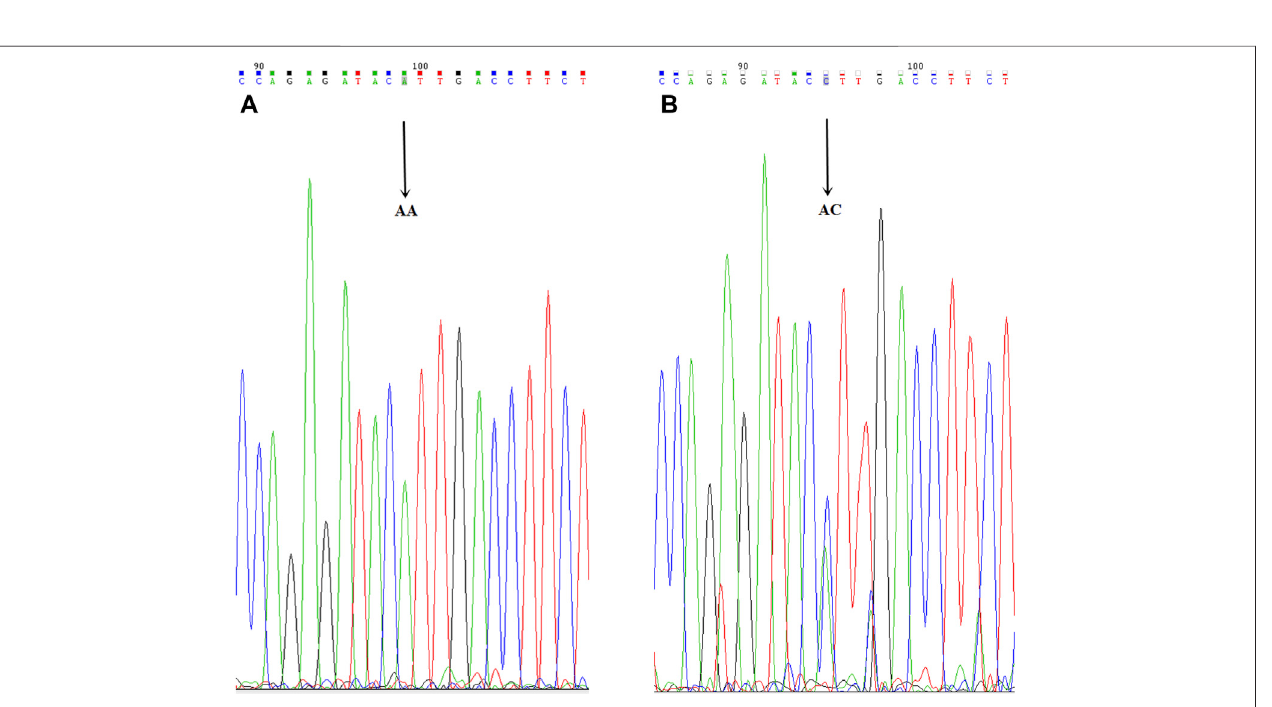
Frontiers in Pharmacology |